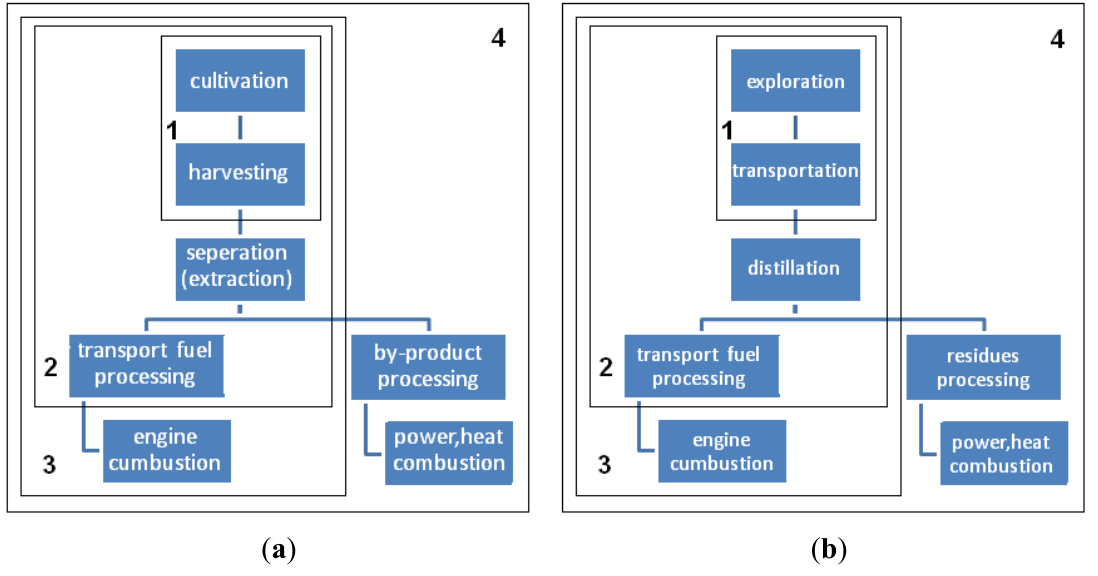
Figure 1. Life-Cycle Inventories (LCI) flow model of biofuel and conventional fossil fuel with different boundaries. ( a ) Biofuel production; ( b ) Fossil fuel